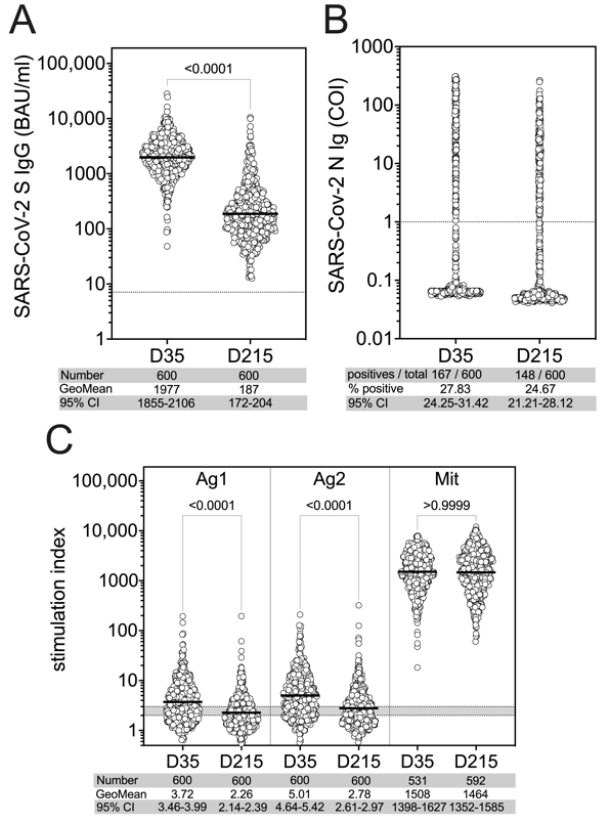
Figure 1. SARS-CoV-2-specific immune responses at D35 and D215 after the second vaccination with BNT162b2. Serum levels of SARS-CoV-2 S- ( A ) and N-specific ( B ) antibodies are shown in samples collected at day 35 and day 215 (D35 and D215). T cell response ( C ) is presented as the stimulation index (SI) calculated as the ratios of IFN- γ values from SARS-CoV-2-specific Ag1 (CD4 peptide pool) and Ag2 (CD4/CD8 peptide pool) as well as mitogen (Mit) stimulations and the respective unstimulated control. Differences of immune parameters between baseline and follow-up were tested by applying non-parametric paired Wilcoxon test ( A , B ) or non-parametric Kruskal–Wallis test followed by Dunn’s multiple comparisons ( C ).